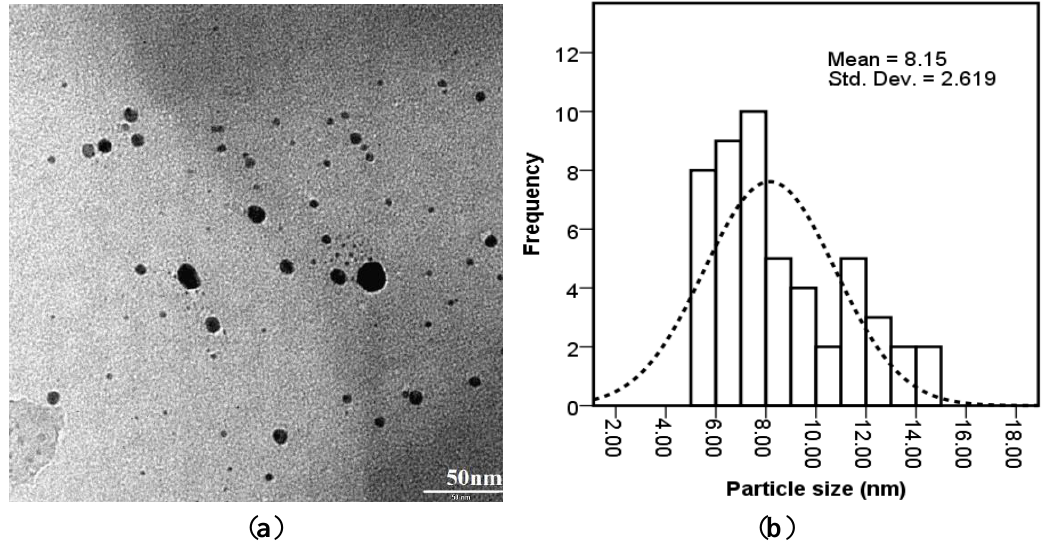
Figure 5. The ( a ) TEM micrograph; and ( b ) particle size distributions of bio-synthesized